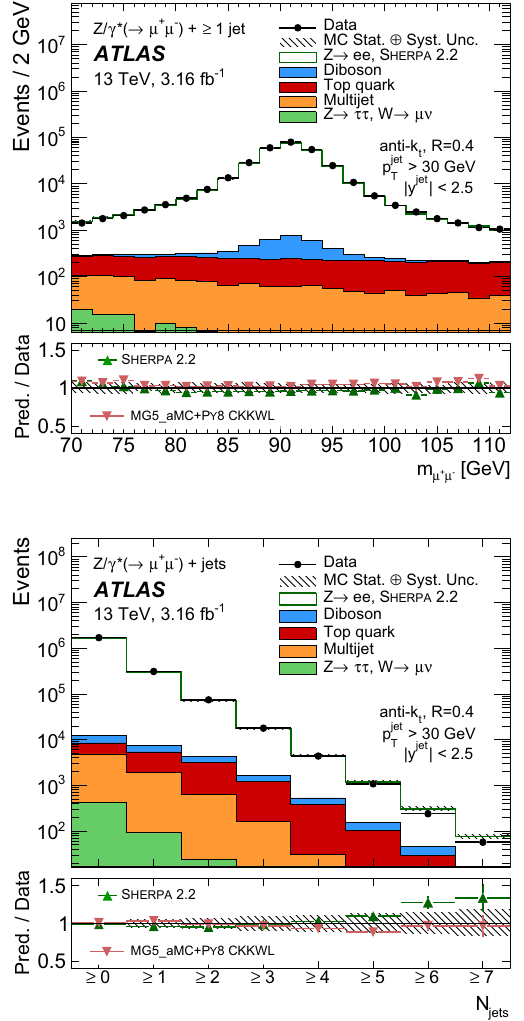
Fig. 1 Dilepton invariant mass for Z + ≥ 1 jet ( top ) and inclusive jet multiplicity ( bottom ) in the Z ( → e + e − ) + jets ( left ) and the Z ( → μ + μ − ) + jets ( right ) channels. All backgrounds and the sig- nal samples are stacked to produce the figures. Systematic uncertainties